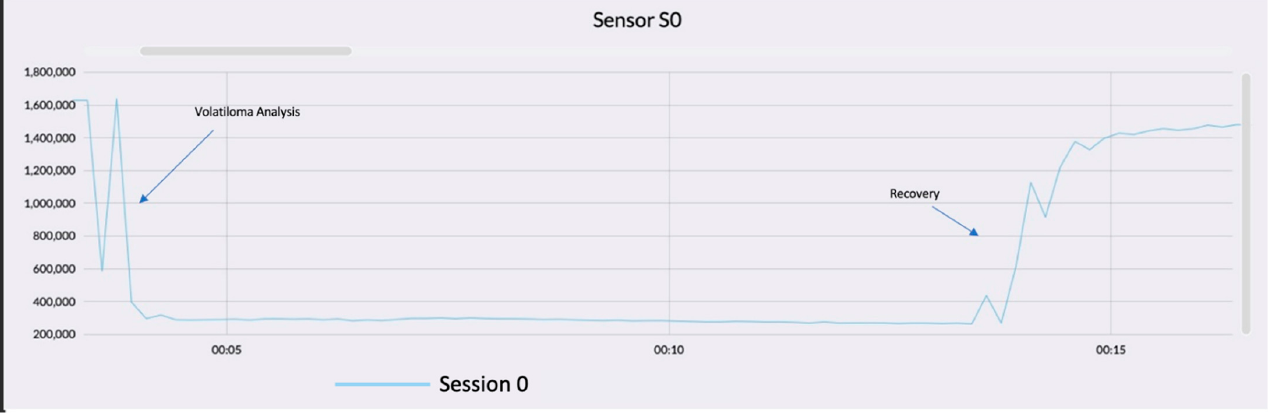
Figure 4. Typical sensor response ( y -axis presents electrical resistance (Ohm), x -axis time shows in